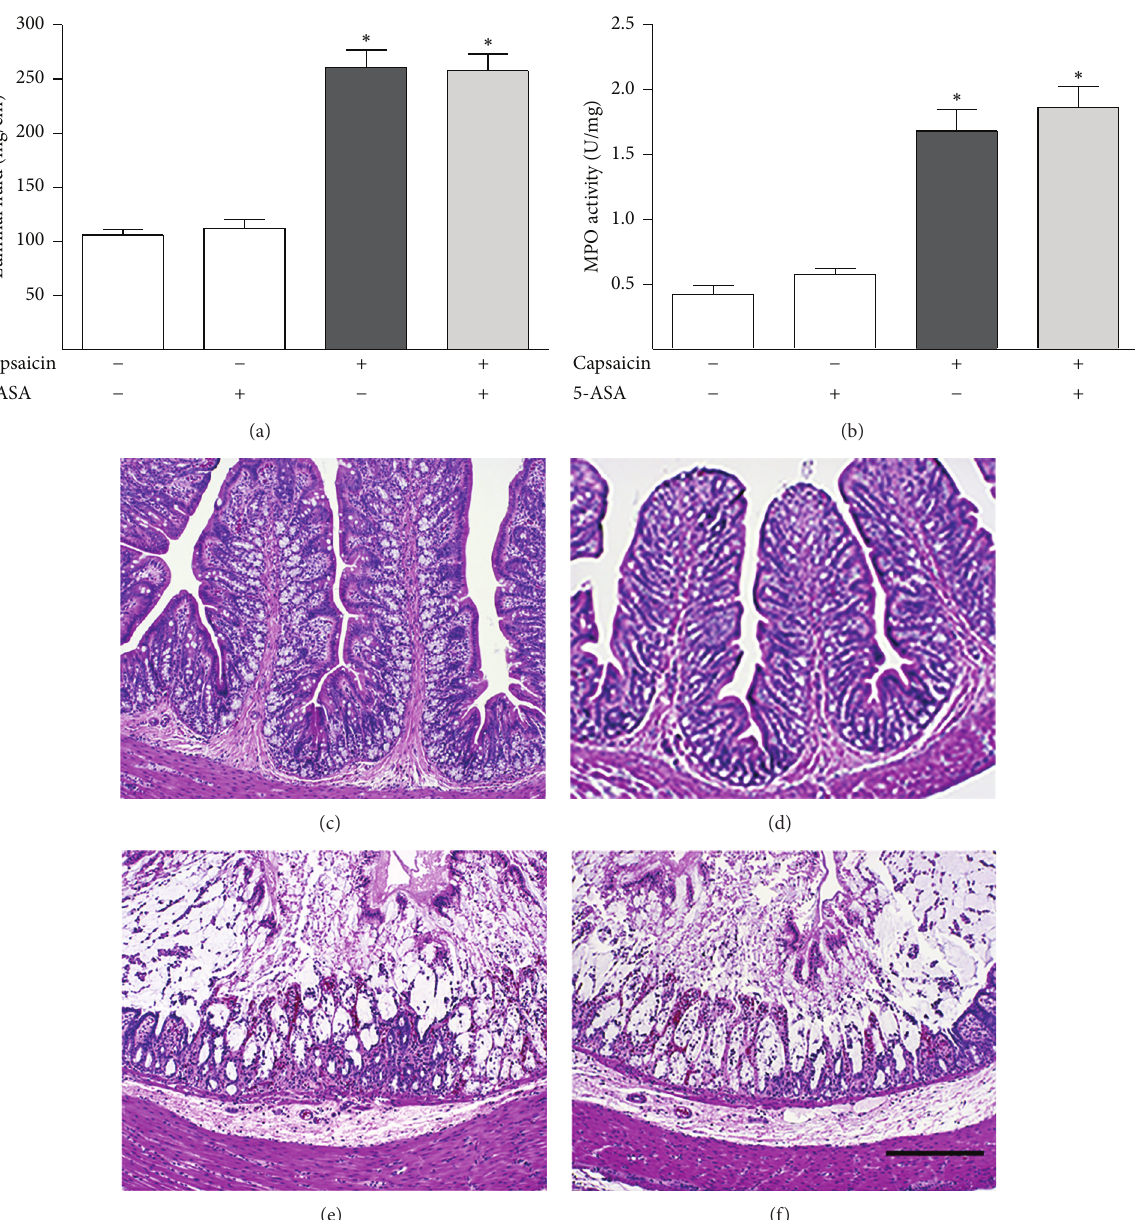
Figure 7: Effects of 5-ASA on capsaicin-induced colonic luminal fluid accumulation and MPO activity. 5-ASA was administered intraluminally at a dose of 100 𝜇 g for 30 minutes before capsaicin. (a) Capsaicin stimulation of colonic luminal fluid accumulation and the lack of significant inhibition of this effect by acute pretreatment with 5-ASA. (b) Capsaicin stimulation of colonic MPO activity and the lack of significant inhibition of this effect by acute pretreatment with 5-ASA. H&E-stained sections of rat colonic segments after they were treated intraluminally for 3 h with vehicle (c), 100 𝜇 g of 5-ASA (d), 4mg of capsaicin (e), or 4 mg of capsaicin after pretreatment with 100 𝜇 g of 5-ASA 30 min before toxin A administration (f). Scale bar, 100 𝜇 m. ∗ 𝑃 < 0.001 versus sulfapyridine-/toxin